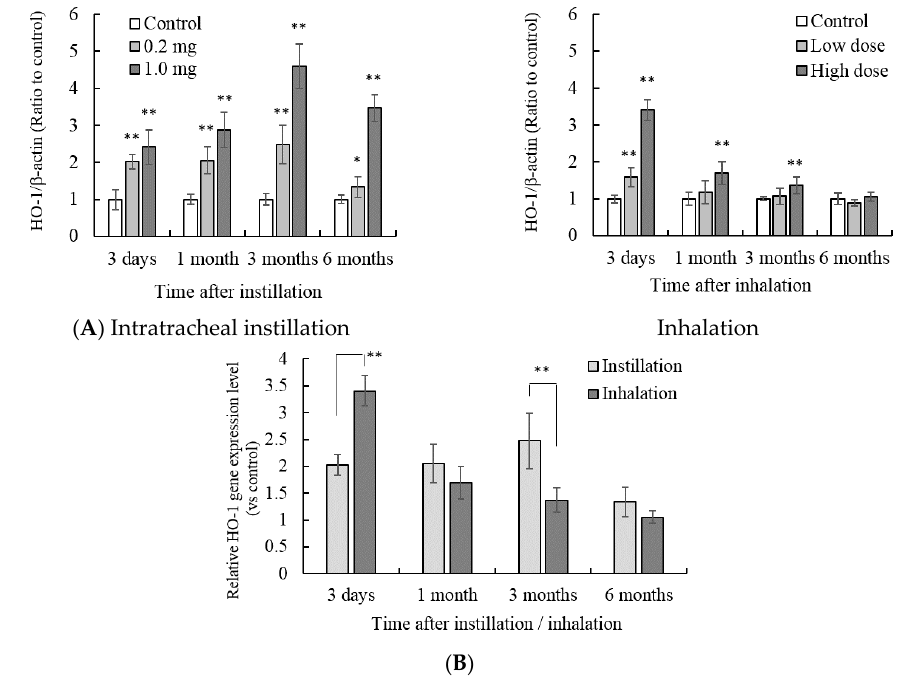
Figure 2. Influence of NiO nanoparticle exposure on the gene expression of HO-1 in the lung. ( A ) ho-1 gene expression in the lung after intratracheal instillation and inhalation. The gene expression of ho-1 was determined by real-time polymerase chain reaction (PCR). Values are mean ± SE ( n = 5). Significant differences versus control group are indicated in the figure (ANOVA, Dunnet). ** p < 0.01, * p < 0.05; ( B ) Comparison of 0.2 mg intratracheal instillation and high dose inhalation. ** p < 0.01 (ANOVA, Tukey).